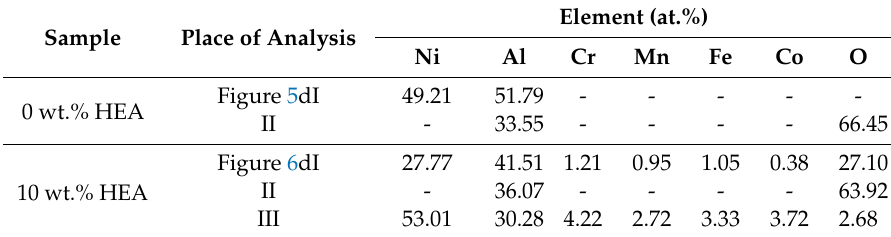
Table 1. Chemical composition of different areas in the sample of 0 wt.% HEA and 10 wt.% HEA. Sample Place of Analysis